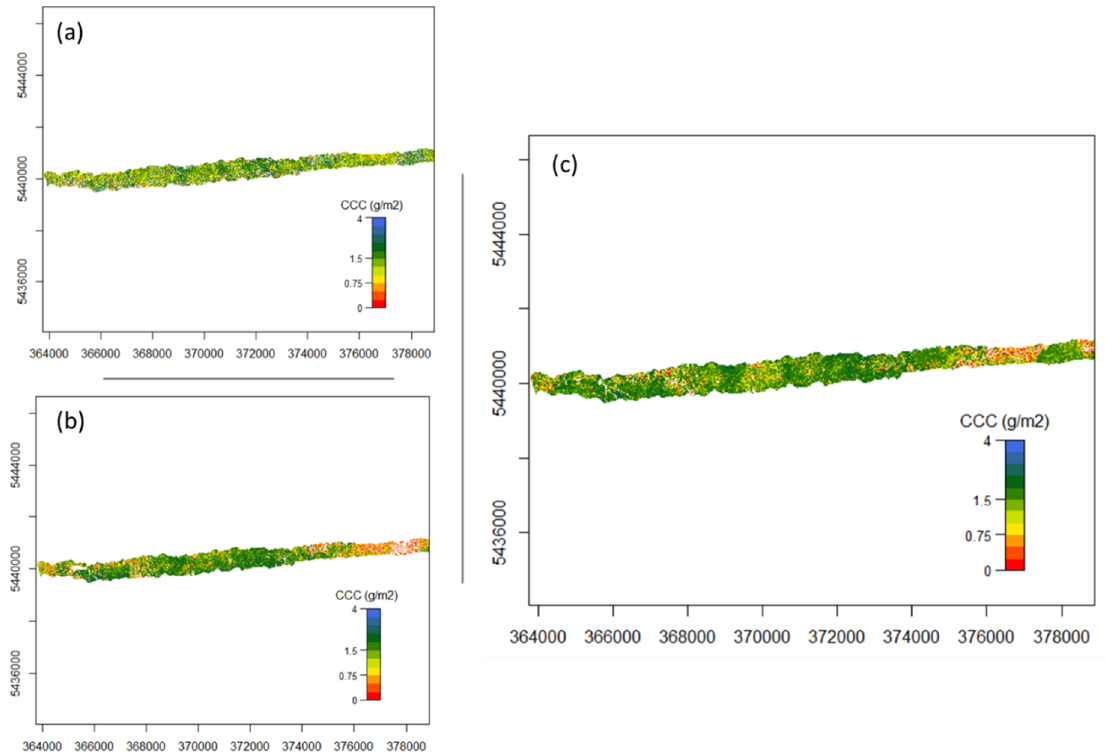
Figure A2. Flight line 193 mapped CCC ( a ) using nMTCI with wavelength 1 = 1819.52 nm, wavelength 2 = 1996.52 nm and wavelength 3 = 390.07 nm, ( b ) using nDD with wavelength 1 = 528.83 nm and wavelength 3 = 735.02 nm, and ( c ) using PLSR.